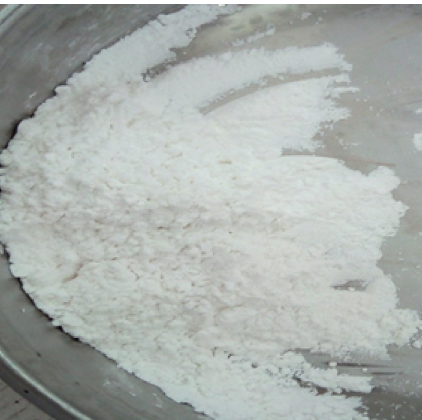
Figure 1: Powdered alum sample produced from bauxite waste in